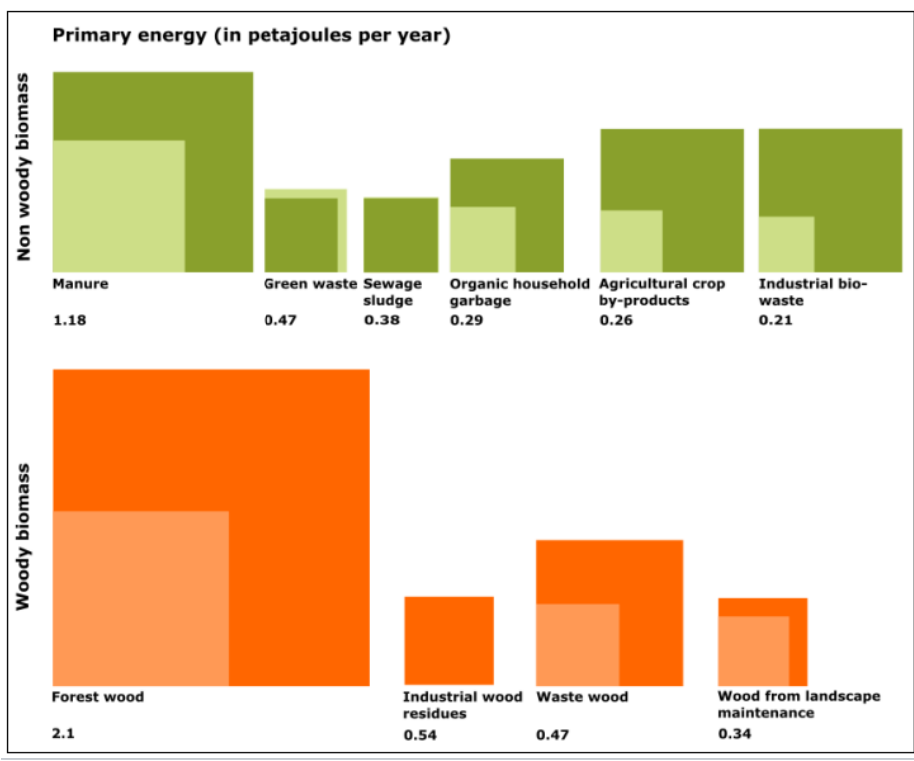
Figure 2. Theoretical (darker) and sustainable (lighter) biomass potential of canton Aargau differentiated by biomass type.